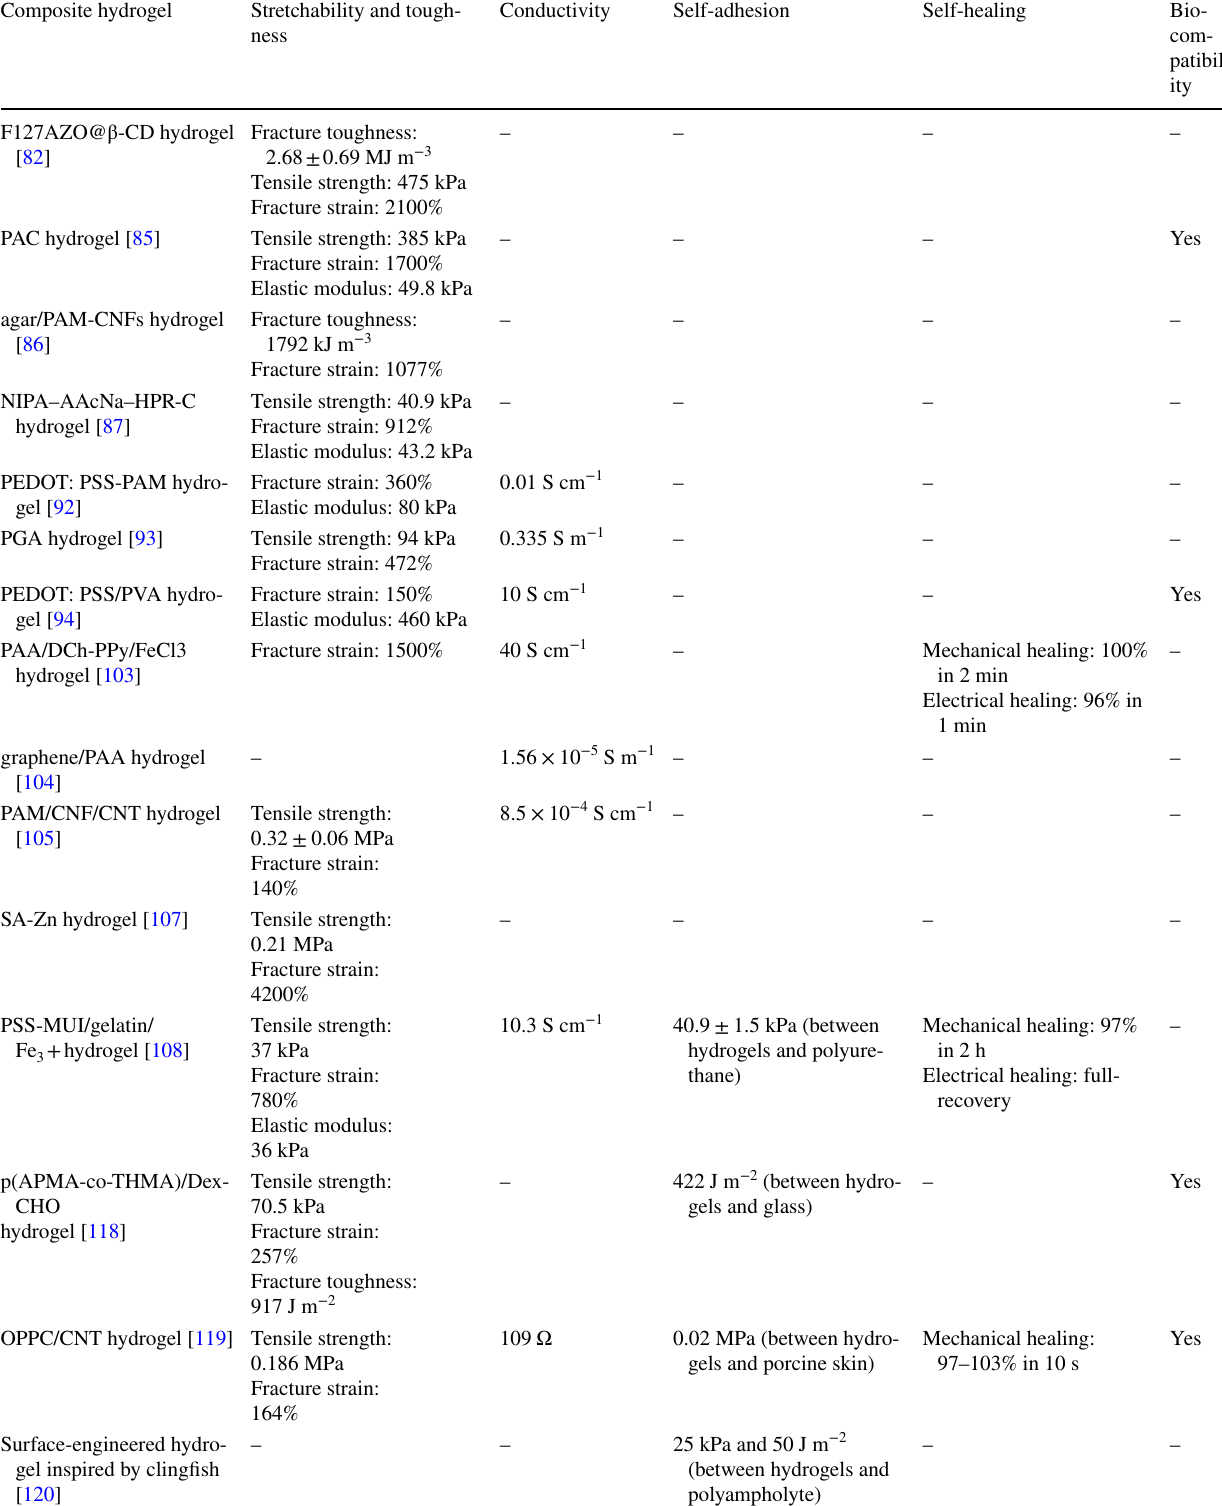
Table 2 Summary of performances of diverse composite hydrogels Composite hydrogel Stretchability and tough- Conductivity ness